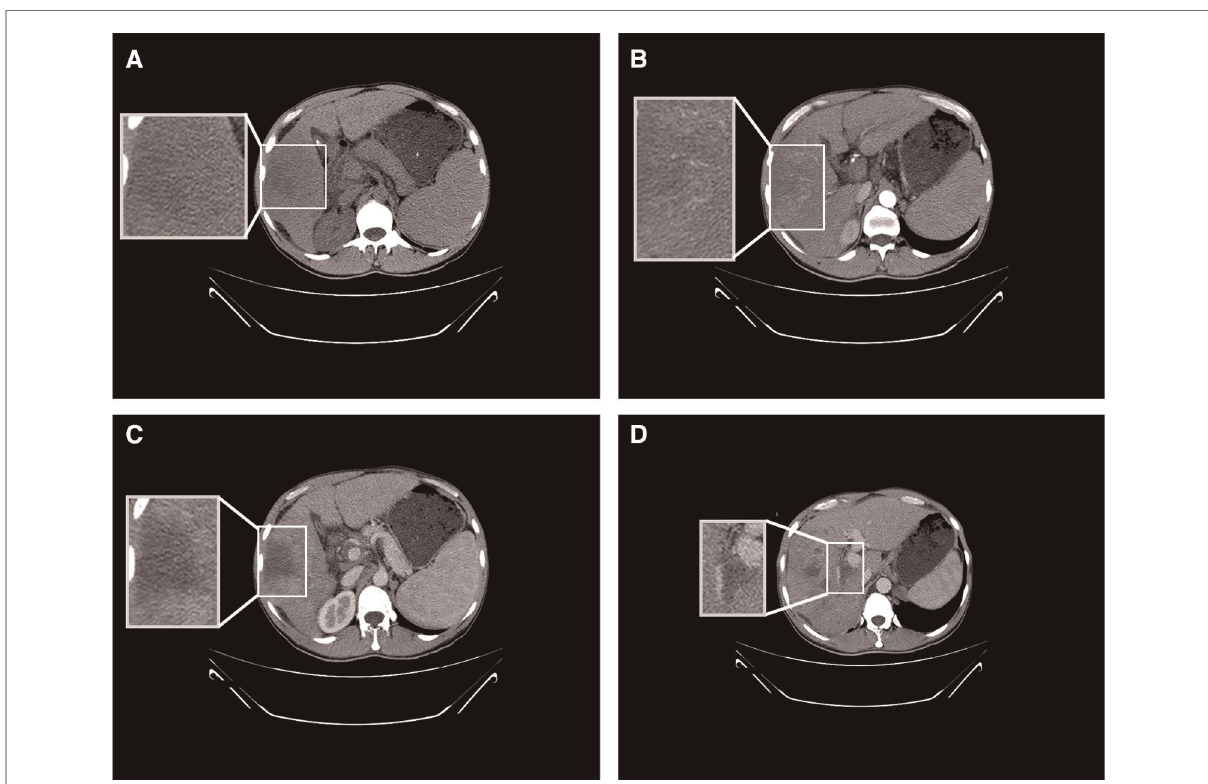
FIGURE 1 Results of CT conducted on 3 May 2019. ( A ) Upper abdominal CT depicting a low-density shadow in the right lobe of the liver. ( B ) Enhanced CT showing uneven enhancement of the shadow in the right lobe of the liver at the artery stage. ( C ) Enhanced CT indicating fast enhancement regression of the shadow in the right lobe of the liver at the vein stage. ( D ) Enhanced CT depicting tumor thrombus formation in the portal